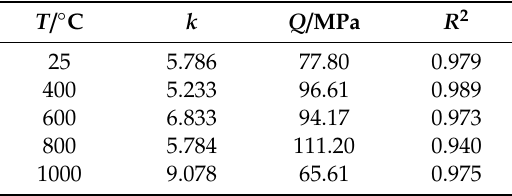
Table 1. Strength characters of samples under conventional triaxial compression after temperature.